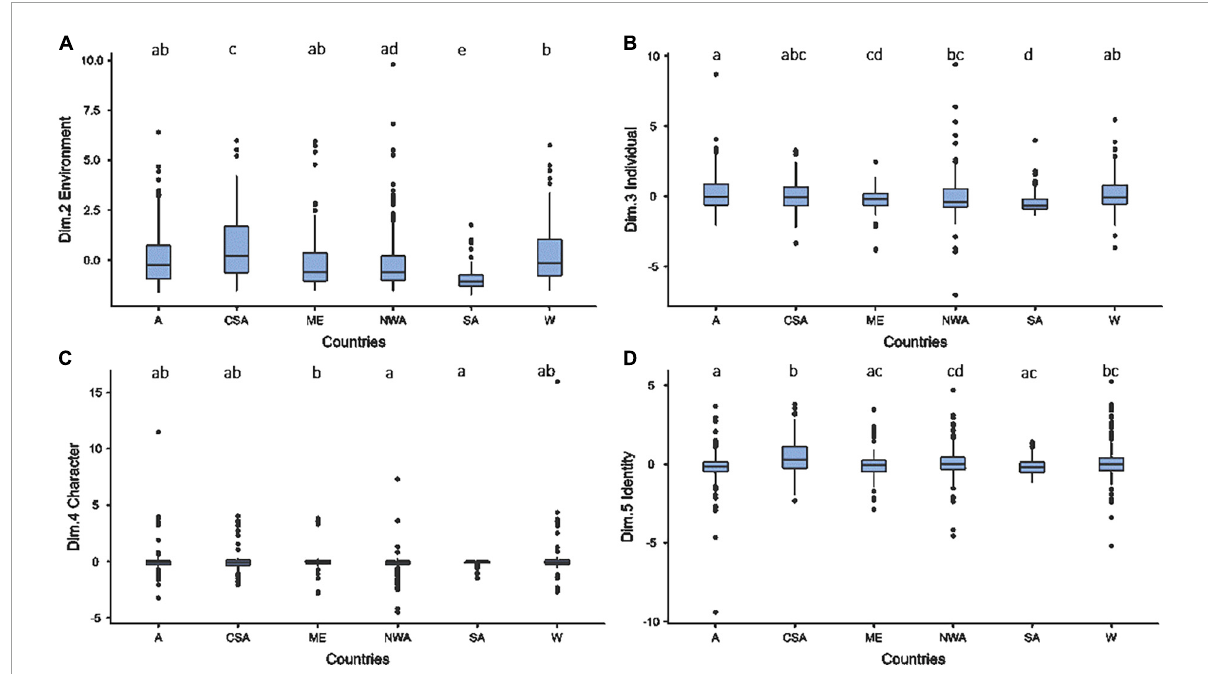
FIGURE6 Comparison of children’s drawing behavior for (A) the dimension 2 (i.e., environment), (B) the dimension 3 (i.e., individual), (C) the dimension 4 (i.e., character) and (D) the dimension 5 (i.e., identity). The countries groups that have no letters in common differ